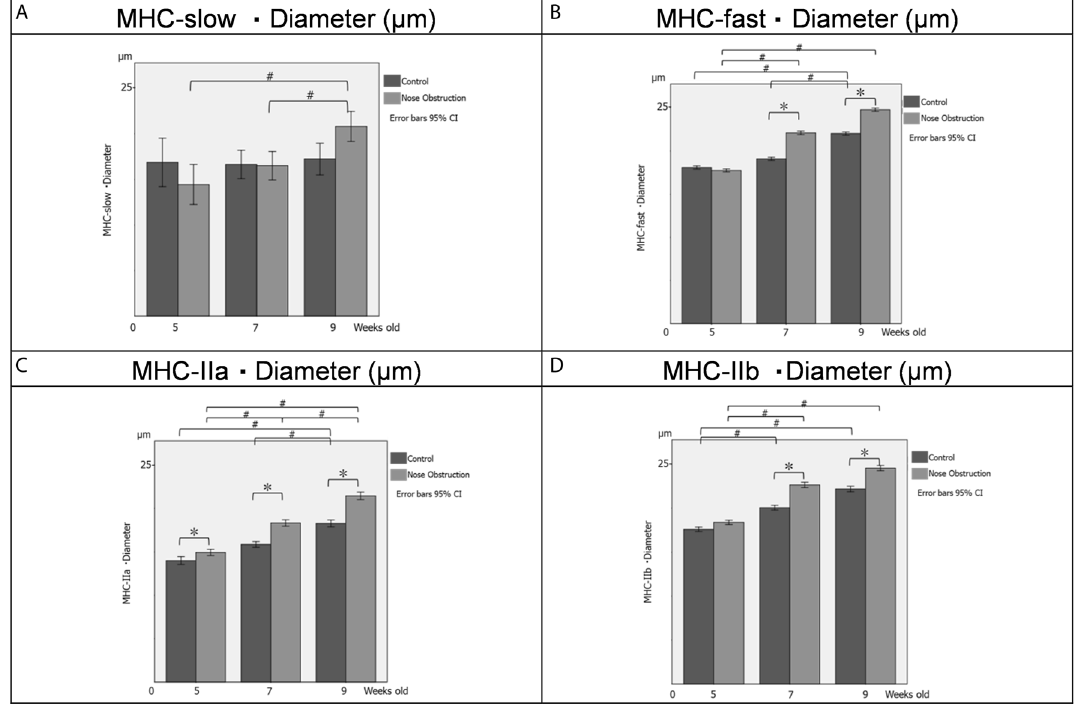
Figure 3. Diameter of the genioglossus muscle fibers. ( A ) Diameter of the slow-type muscle fibers at 5, 7 and 9 weeks old. ( B ) Diameter of the fast-type muscle fibers at 5, 7 and 9 weeks old. ( C ) Diameter of the fast IIa-type muscle fibers at 5, 7 and 9 weeks old. ( D ) Diameter of the fast IIb-type muscle fibers at 5, 7 and 9 weeks old. Bars in black, Control group; bars in grey, nose obstruction group. The x-axis shows the age of the rats, the y-axis shows the diameter measurement of muscle fibers, for both control and nose obstruction groups. A repeated- measures multivariate analysis of variance was performed for intergroup and intragroup statistical comparisons. A simple main-effects analysis with Sidak adjustment was performed for multiple comparisons. Data are expressed as mean ± standard deviation. * ,# P < 0.05. Error bars at 95% confidence interval. MHC-slow Myosin heavy chain expression of slow-type muscle fiber, MHC-fast Myosin heavy chain expression of fast-type muscle fiber, MHC-IIa Myosin heavy chain expression of IIa fast-type muscle fiber, MHC-IIb Myosin heavy chain